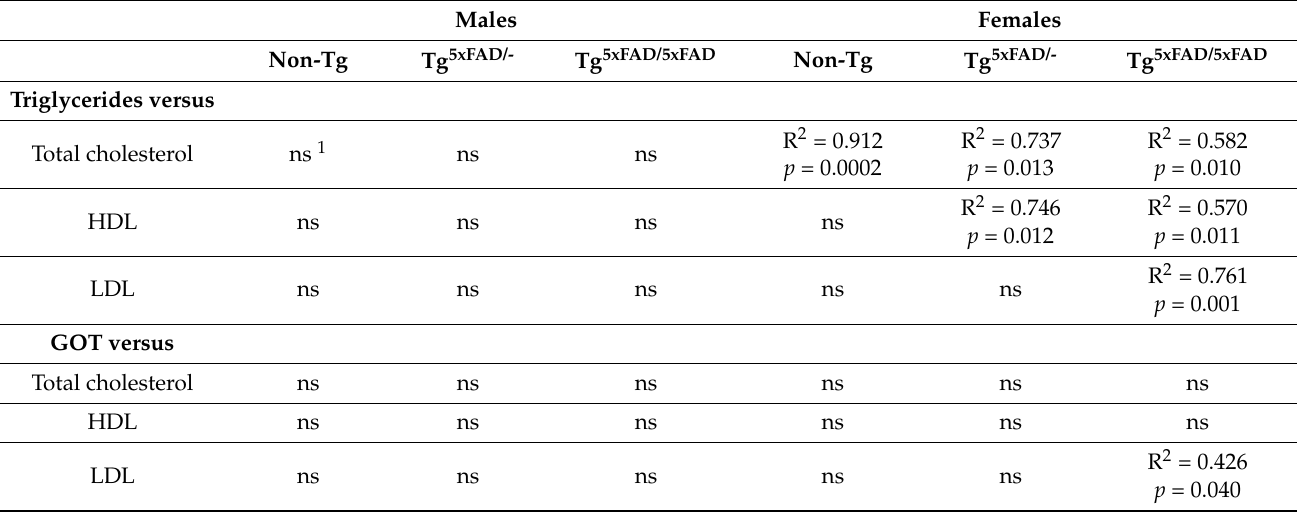
Table 5. Correlations between cholesterol levels and triglyceride levels or glutamic oxaloacetic transaminase (GOT) in the plasma of 5xFAD mice at 6 months of age. Males